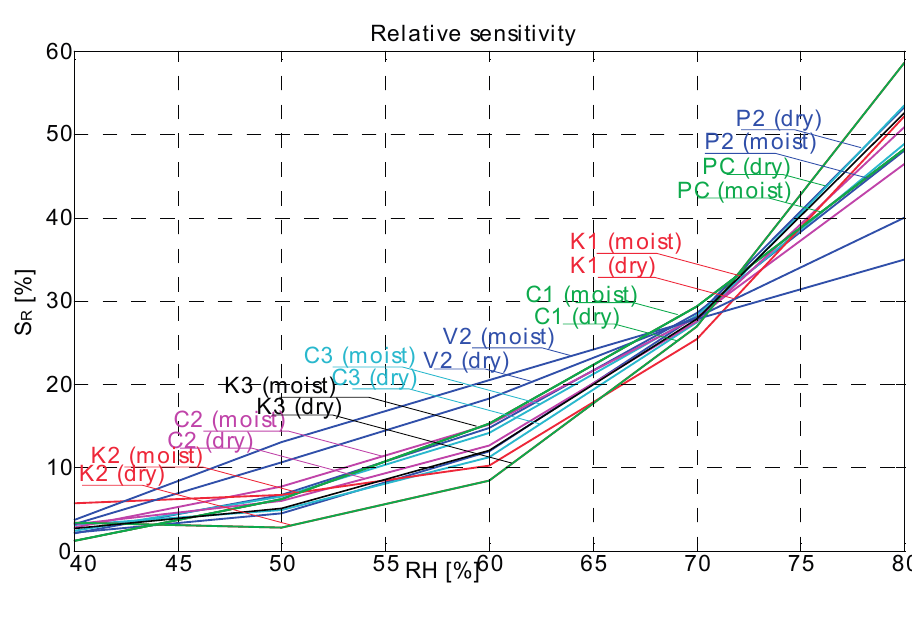
Figure 7. Relative sensitivity plot.